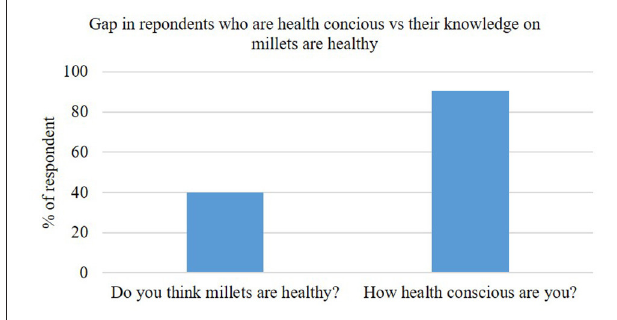
FIGURE 6 | Gap in respondents who are health conscious vs. their knowledge on millets health